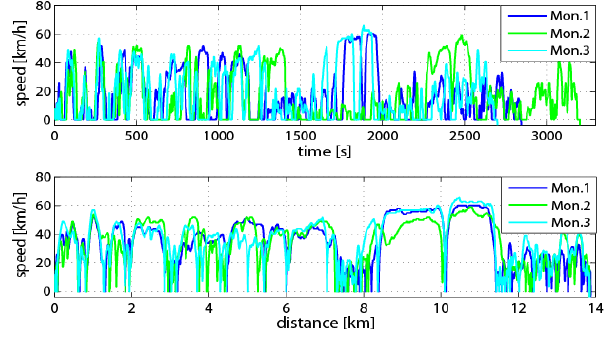
Figure 4. Traffic speed information on Mondays in three weeks. ( a ) The instantaneous speed vs . time and vs . distance; ( b ) the average speed vs .